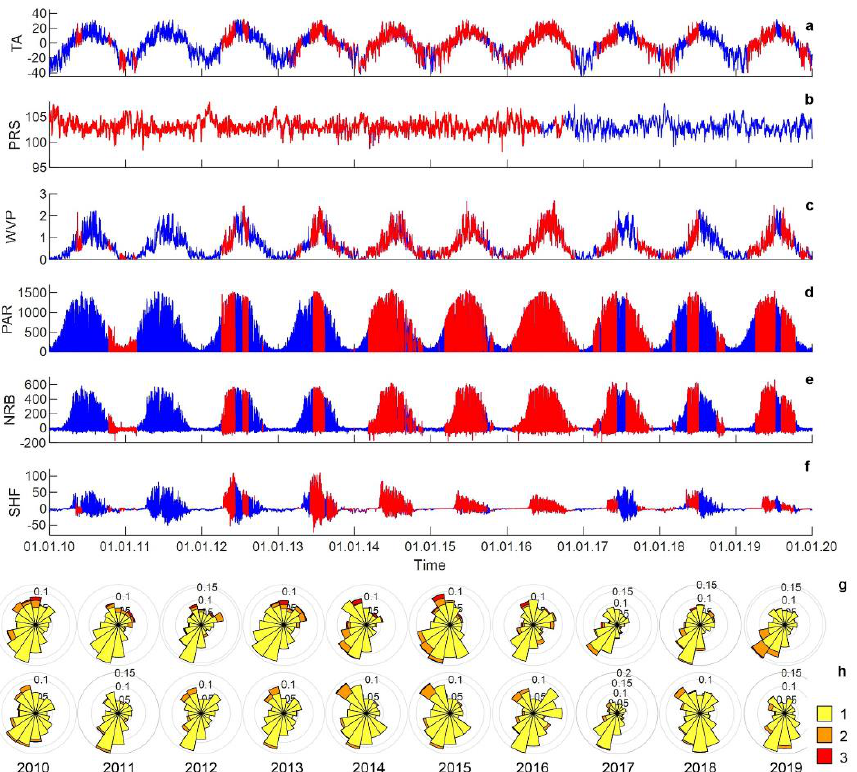
Figure 4. Meteorological data recorded at the ridge site at MFS. Legend: ( a ), air temperature (°C); ( b ), atmospheric pressure (kPa); ( c ), vapor pressure (kPa); ( d ), photosynthetically active radiation (µmol m −2 s −1 ); ( e ), net radiation (W m −2 ); ( f ), soil heat flux (W m −2 ); ( g ), wind rose at 10 m; ( h ), wind rose at 2 m. 1: wind speed = 0.5~2 m s −1 . 2: wind speed = 2~ 5 m s −1 . 3: wind speed = >5 m s −1 . Red line = raw observations, blue line = gap-filled data.